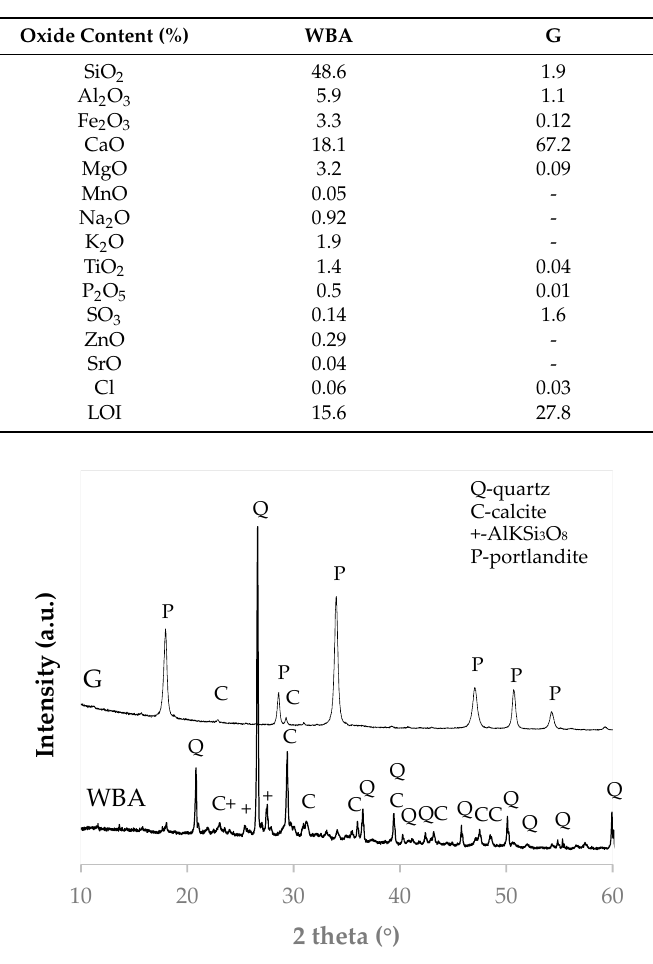
Figure 4. XRD pattern of WBA residue and G by-product.